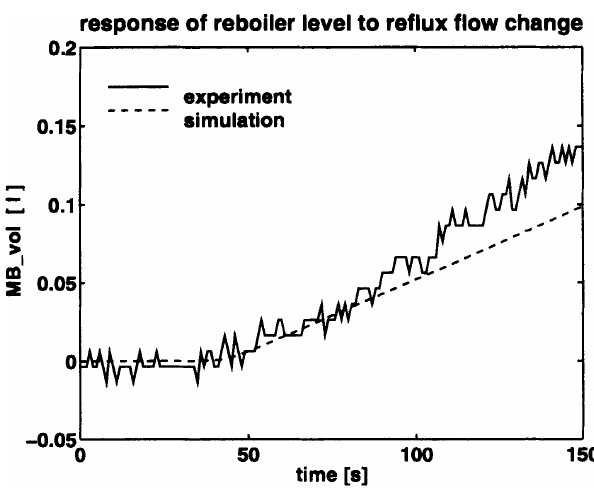
Figure 6. Experiment 5. Response of reboiler level to a step in reflux flow at t ó 20s.